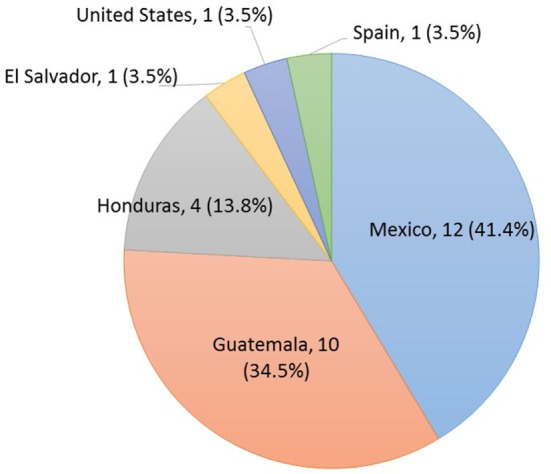
Distribution of country of origin for the U.S. dairy subjects.